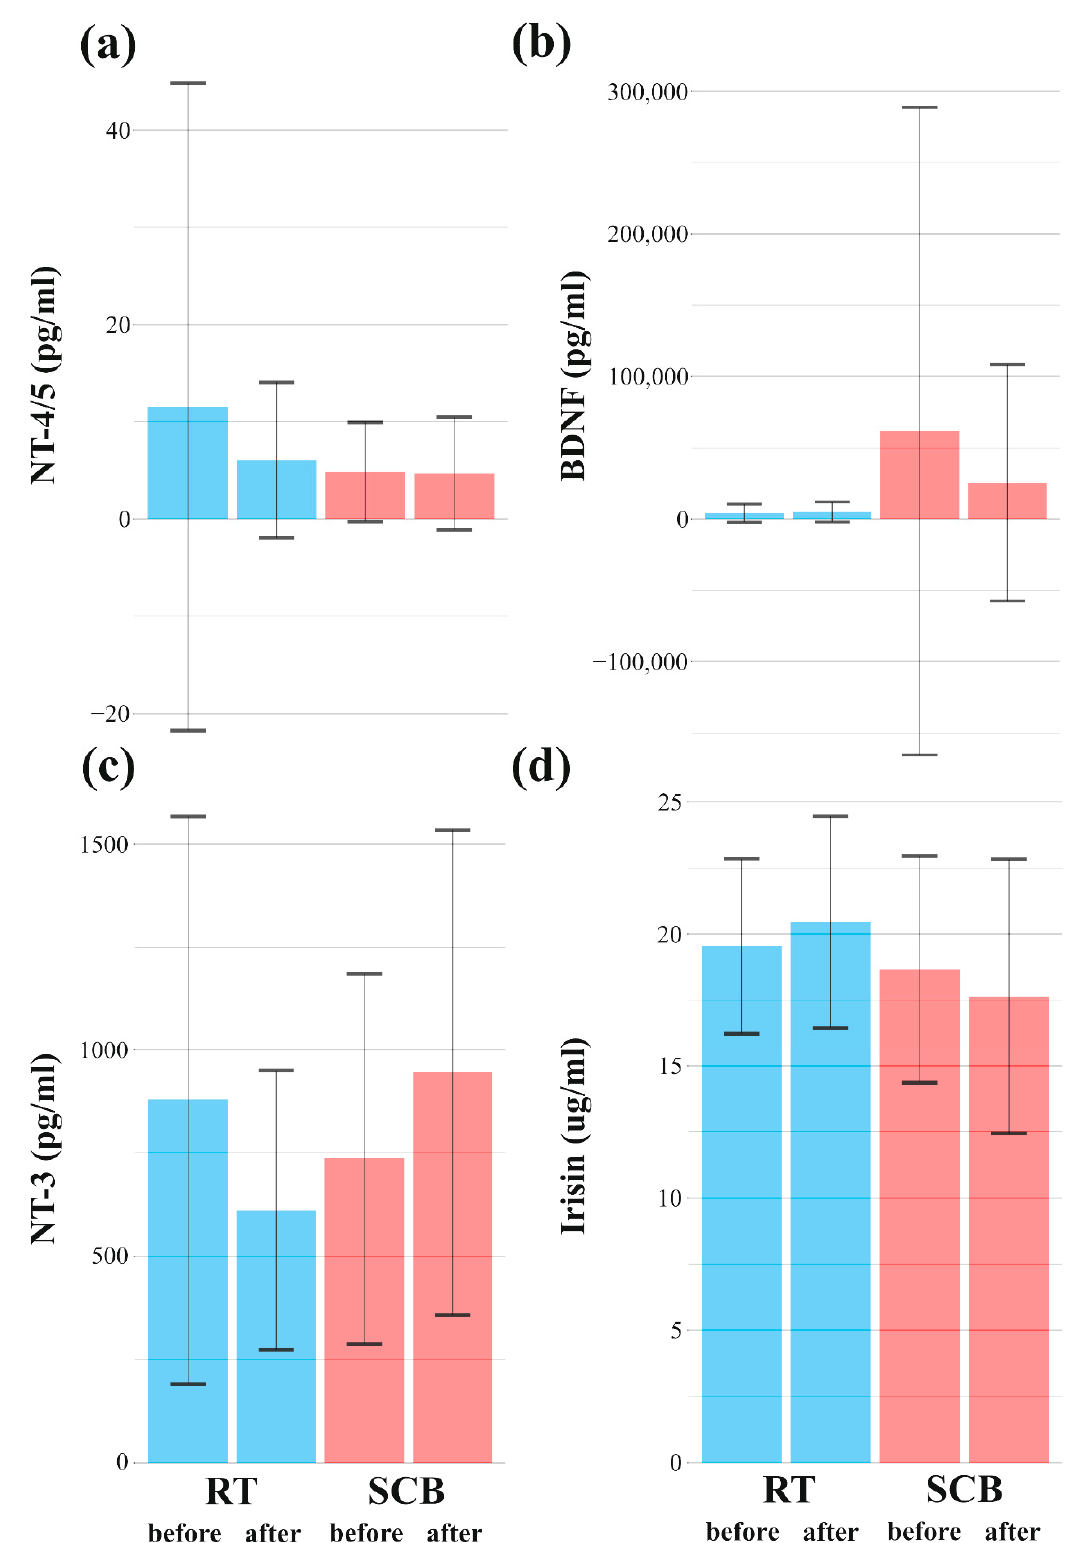
Figure 5. Impact of training programs on neurotrophins. Impact of training programs on: NT-4/5 ( a ), BDNF ( b ), NT-3 ( c ), Irisin ( d ). Results from the RT group are denoted by blue bars, while the SCB group results are denoted by red bars. Whiskers denote SD.